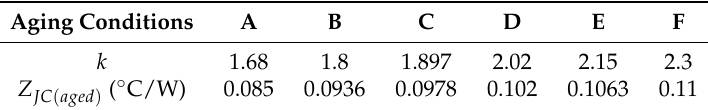
Figure 9. The evolution of k value during the process of solder fatigue. Table 4. The Relationships between k and Z JC ( aged ) .